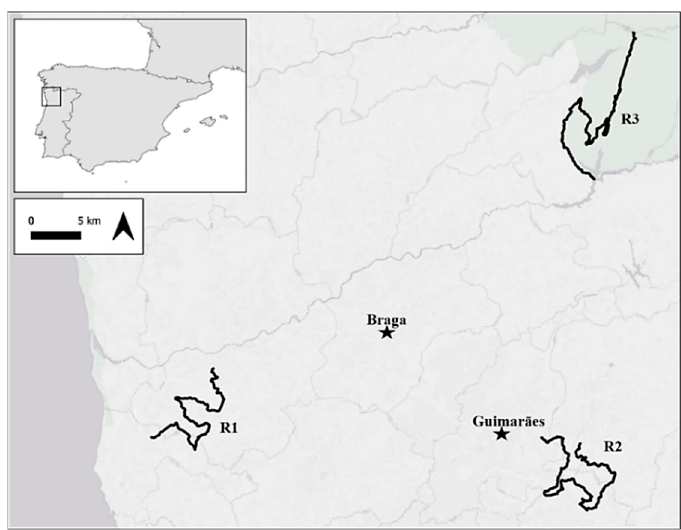
Figure 2. Study area with the three surveyed roads (R1, R2 and R3) in northern Portugal.